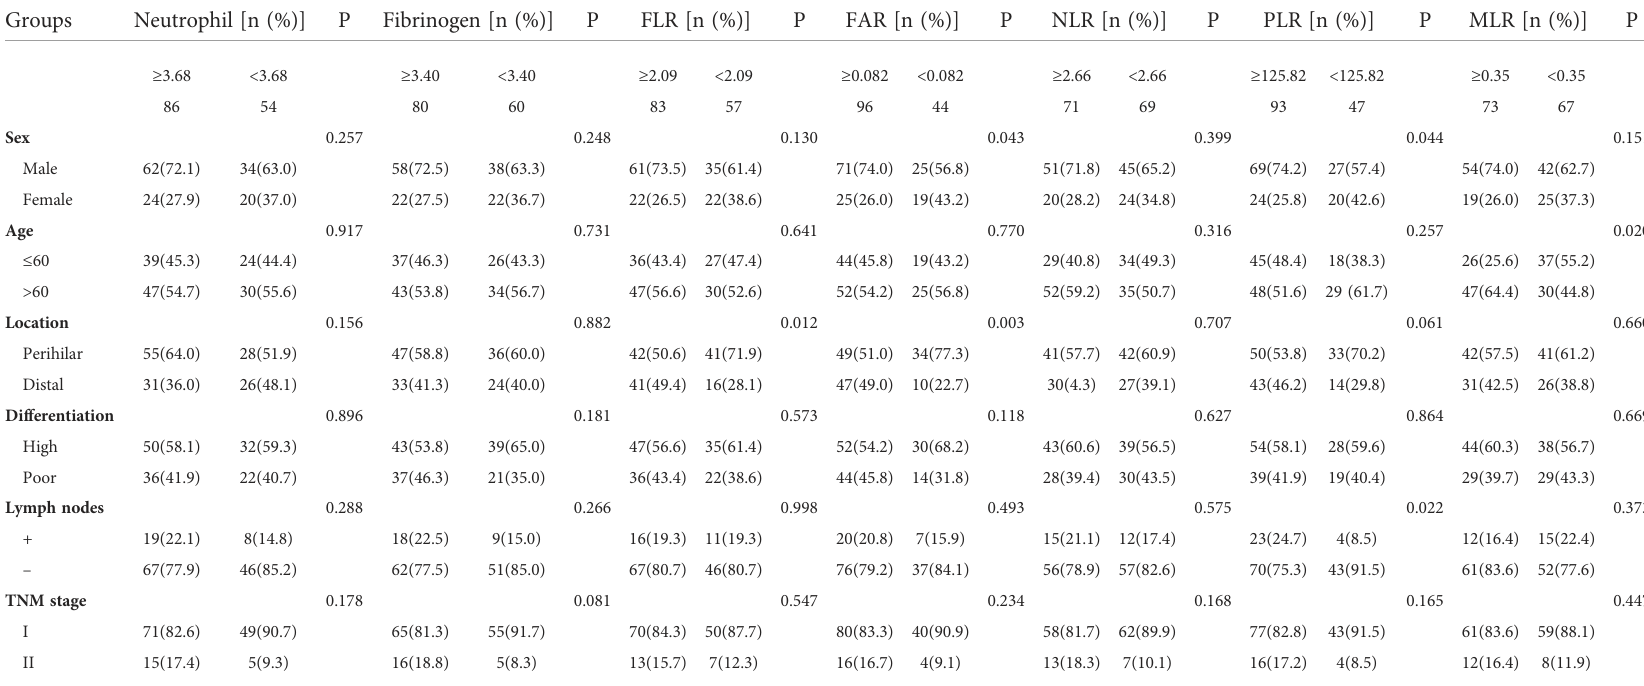
TABLE 3 Correlation between the preoperative in fl ammatory markers and clinicopathological features in patients with ECC.